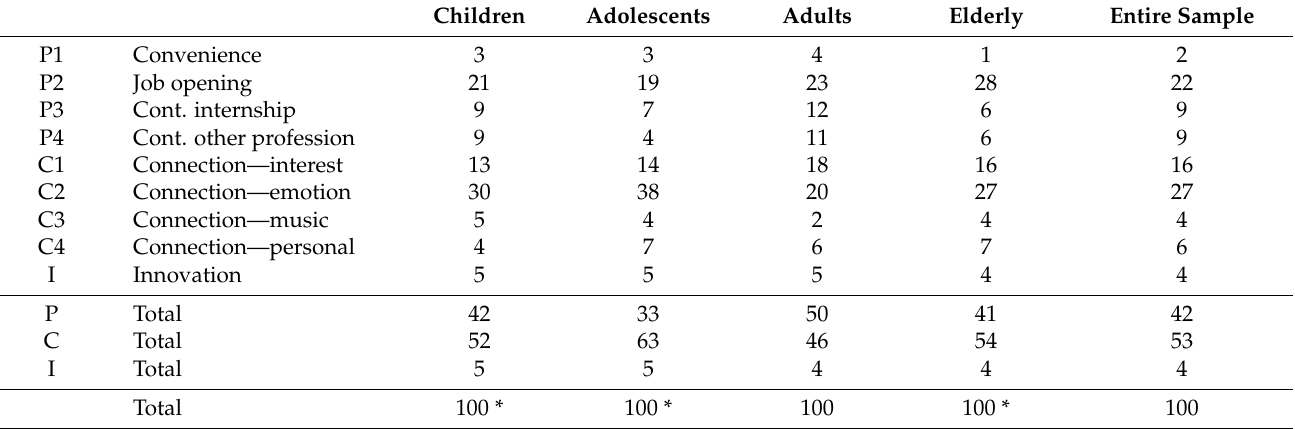
Table 5. Percentage of times that different reasons for working with a clientele were mentioned: cate- gories, subcategories in entire sample and according to age group of population participants work with (children, adolescents, adults, and elderly